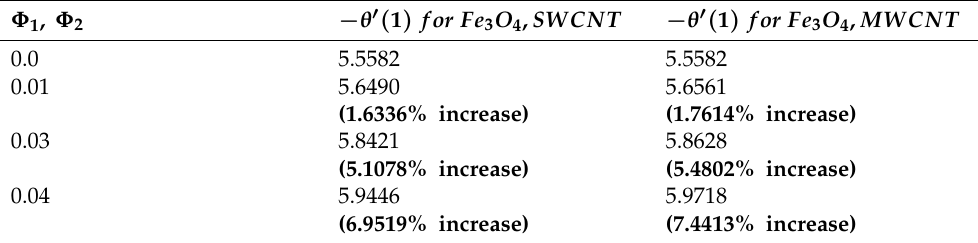
× 100 = Result, Result- Without Nanoparticle